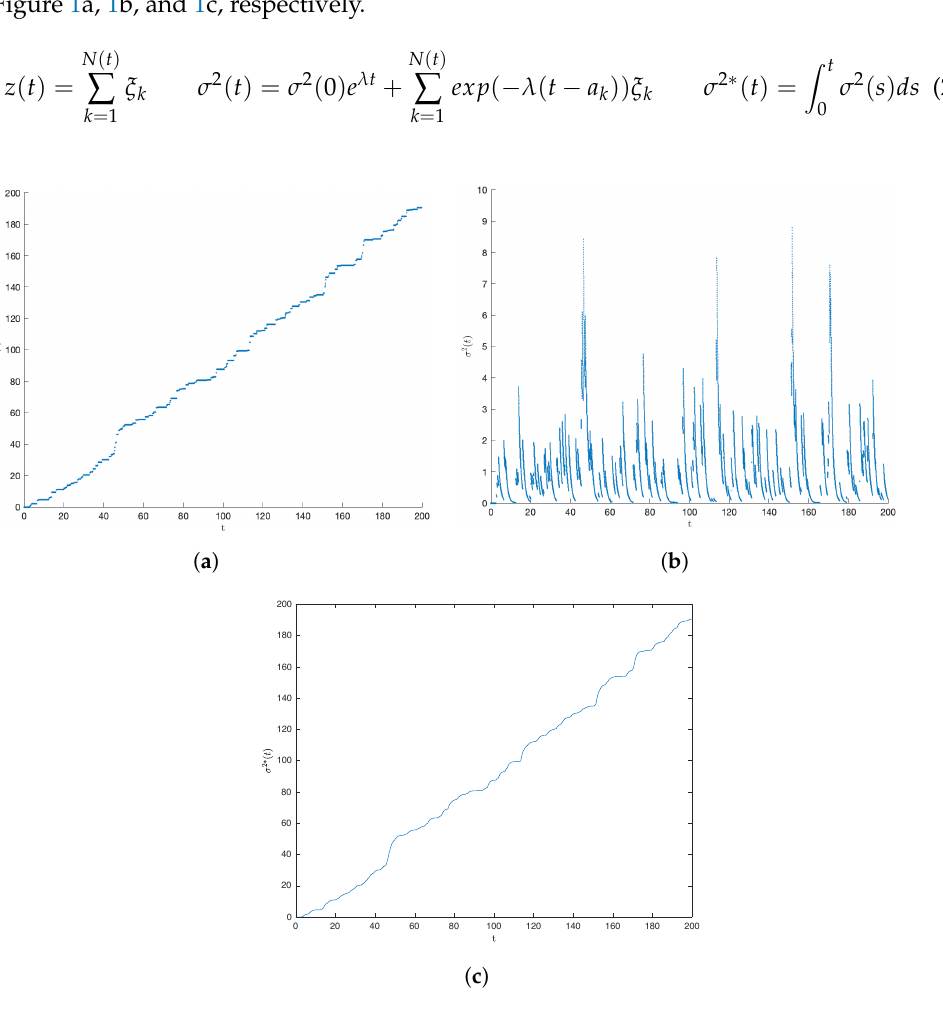
Figure 1. Simulations with ˆ α = 0.8845, ˆ θ = 0.9378: ( a ) compound Poisson process, ˆ z ( t ) ; ( b ) Gamma process, ˆ σ 2 ( t ) ; ( c ) subordinator, ˆ σ 2 ∗ ( t )